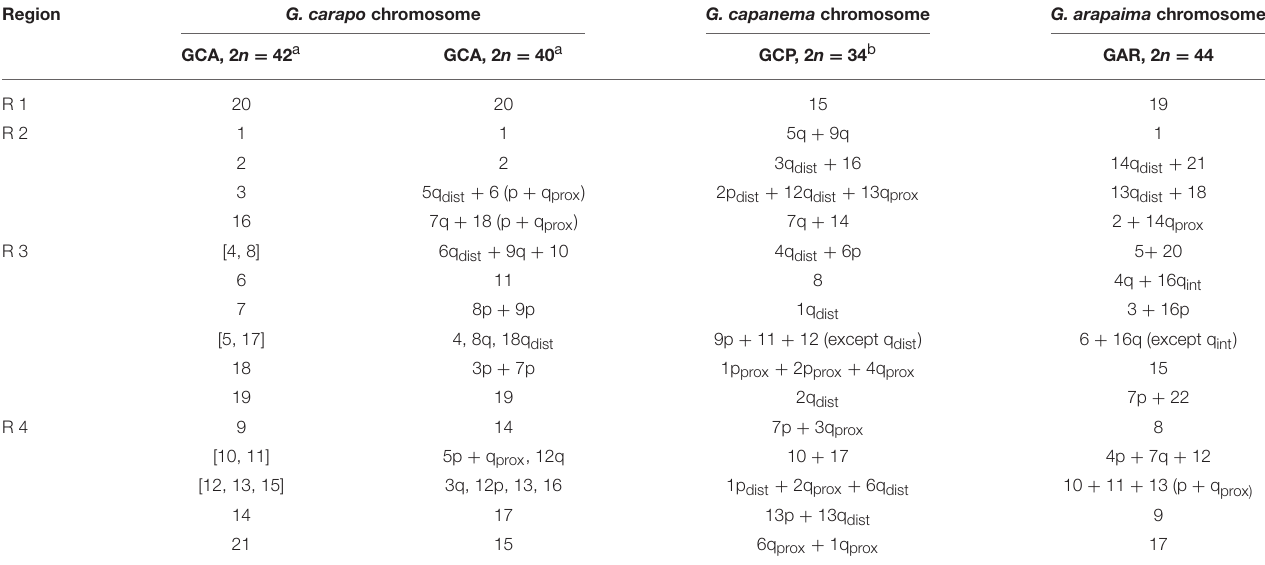
TABLE 2 | Chromosome homologies between G. carapo (2 n = 42), G. carapo (2 n = 40), G. capanema (2 n = 34), and G. arapaima (2 n = 44).